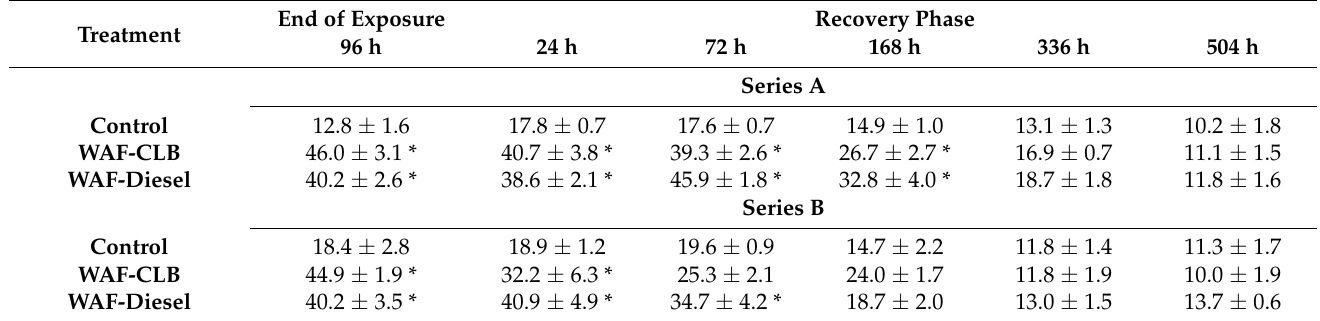
Table 5. Fraction of lysosomal membrane destabilization (LDI) in lobster’ hemocyte cells for each treatment (Control, WAF-CLB, and WAF-Diesel) during the recovery period in series A and B. Mean ± SE; n = 3. Treatment